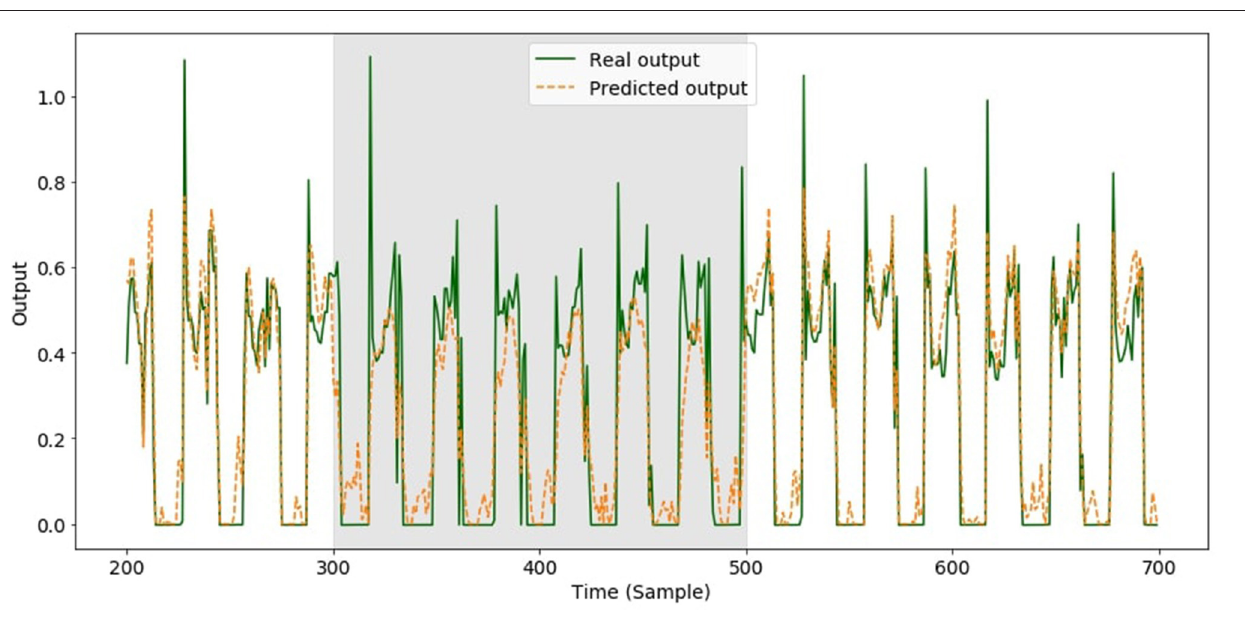
Frontiers in Neurorobotics |